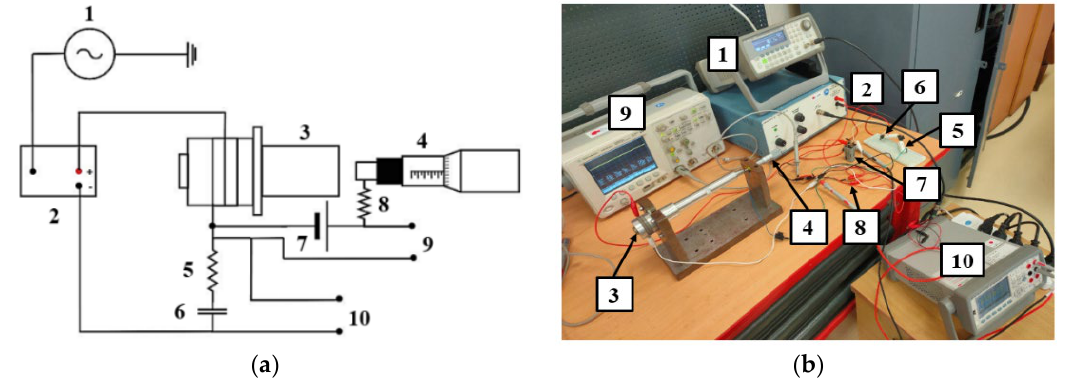
Figure 14. ( a ) A schematic diagram of the amplitude measuring setup: (1) function generator, (2) power amplifier, (3) transducer, (4) micrometer head, (5) resistance 103 ohm, (6) capacitor of 47µF/50v, (7) DC battery (9 volt), (8) resistance 100 kilo ohm, (9) oscilloscope channel, (10) digital multimeter; ( b ) A photograph of the amplitude measuring setup.